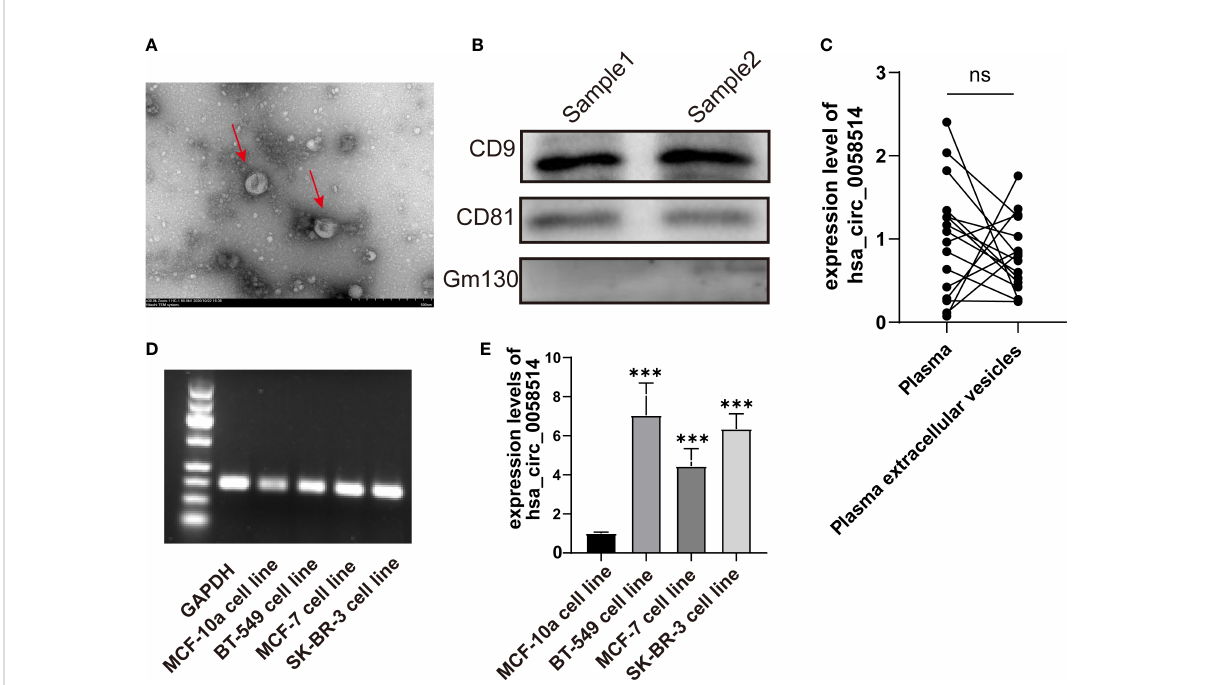
FIGURE 5 The detection of EVs in BC patients. (A) EVs with a diameter of 100 – 500 nm observed by transmission electron microscopy. (B) . Membrane marker proteins CD9 and CD81 detected by Western blotting. (C) The detection and (D) the quantitative results of hsa_circ_0058514 in EVs of four BC cell lines; the size was 166 bp. (E) The expression level of hsa_circ_0058514 in plasma and plasma extracellular vesicle of 16 BC patients. ***P < 0.001; ns, nonsigni fi